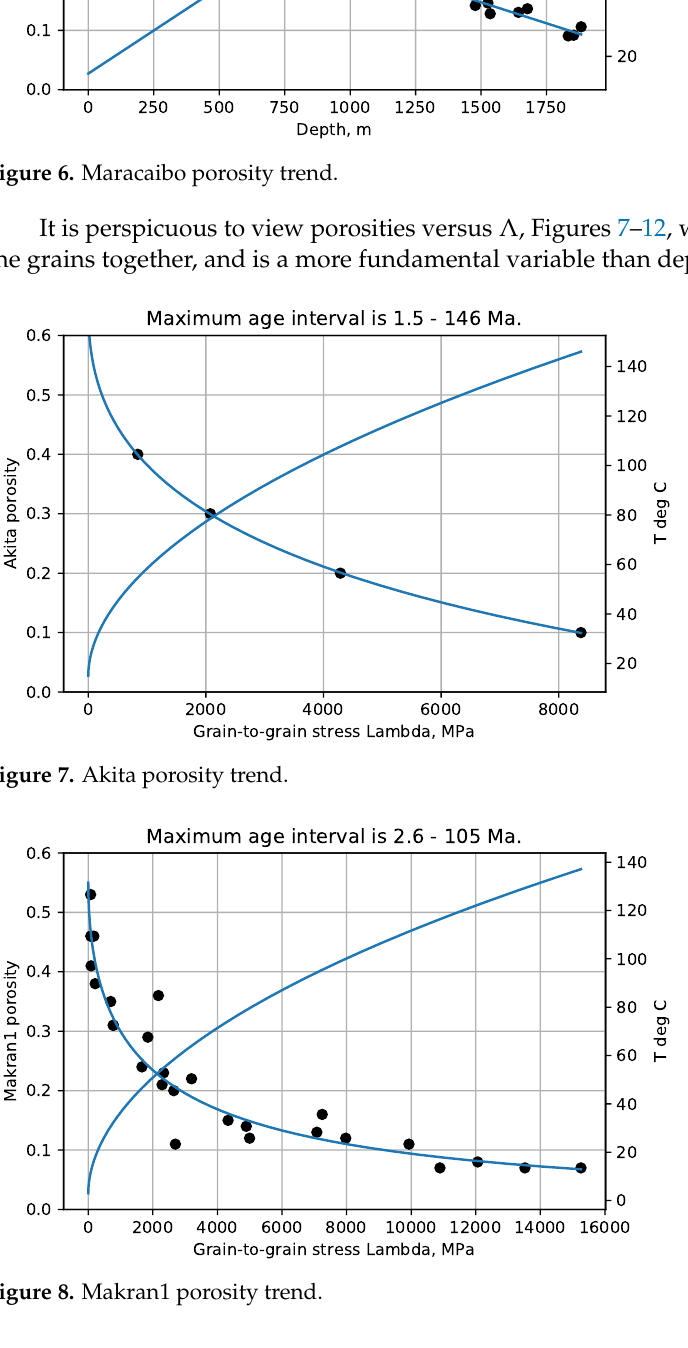
Figure 8. Makran1 porosity